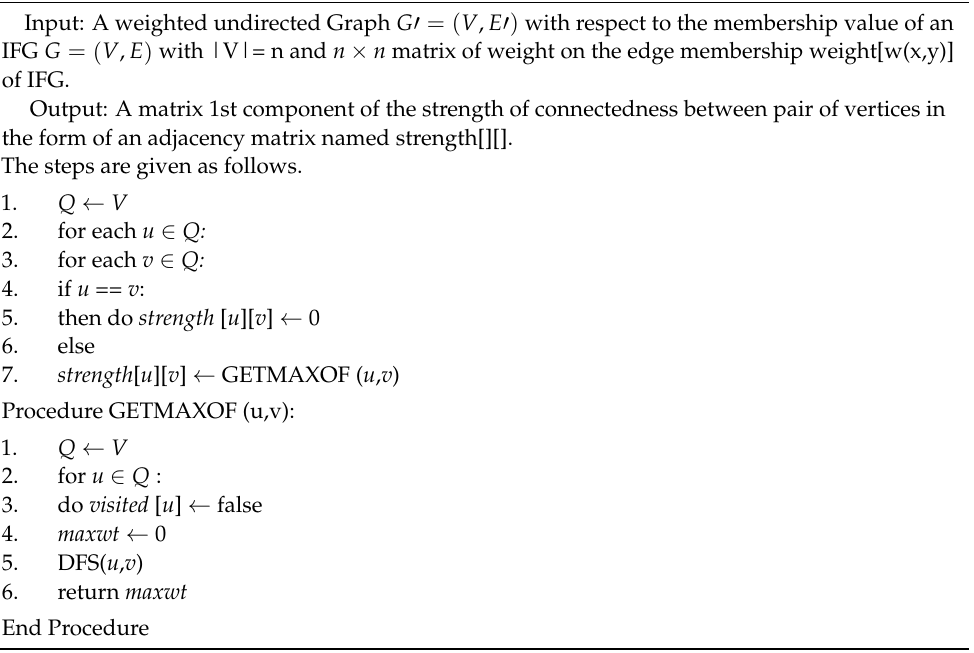
Algorithm 1: Algorithm to find the 1st component of the strength of connectedness between pair of vertices in the form of an adjacency matrix of an IFG G = ( V , E )